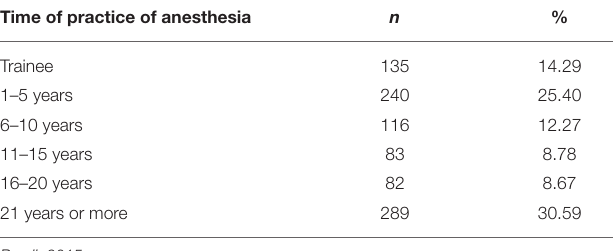
TABLE 5 | Magnesium sulfate intravenous doses most commonly used in the induction of general anesthesia and sedation ( n =